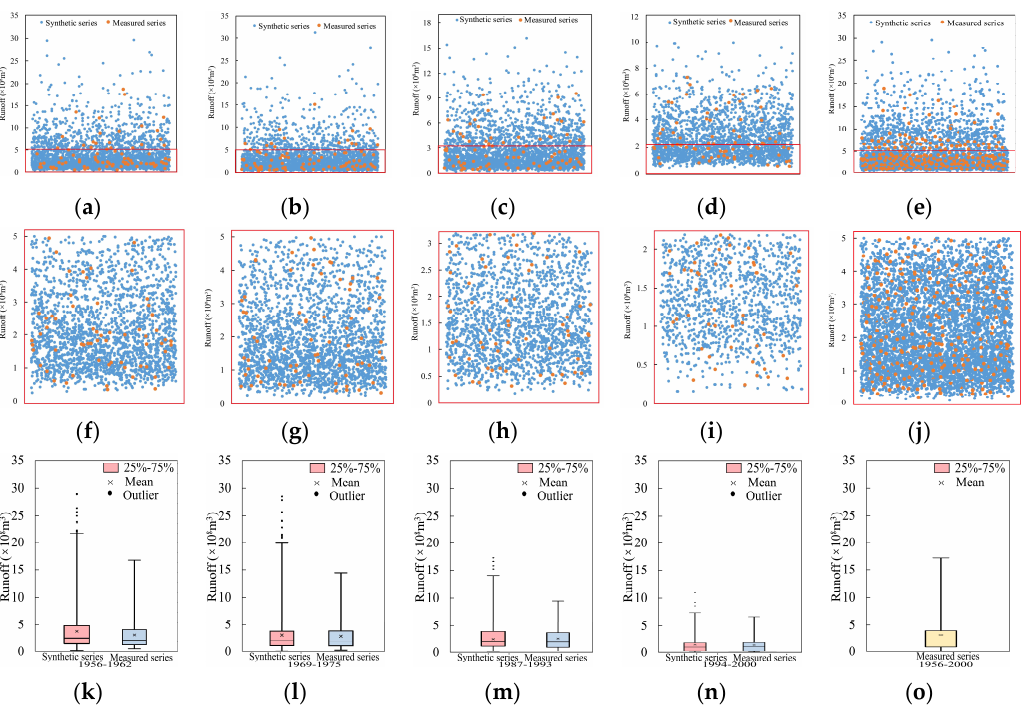
Figure 13. Scatter diagram ( a – d ) and boxplots ( k – n ) of the synthetic series and measured series in four segments at Xianyang gauge; ( e ) a scatter diagram of all the synthetic data and the whole original measured data, ( o ) the boxplots of the whole series. ( f – j ) The amplified diagram of the area enclosed by red lines in a scatter diagram.